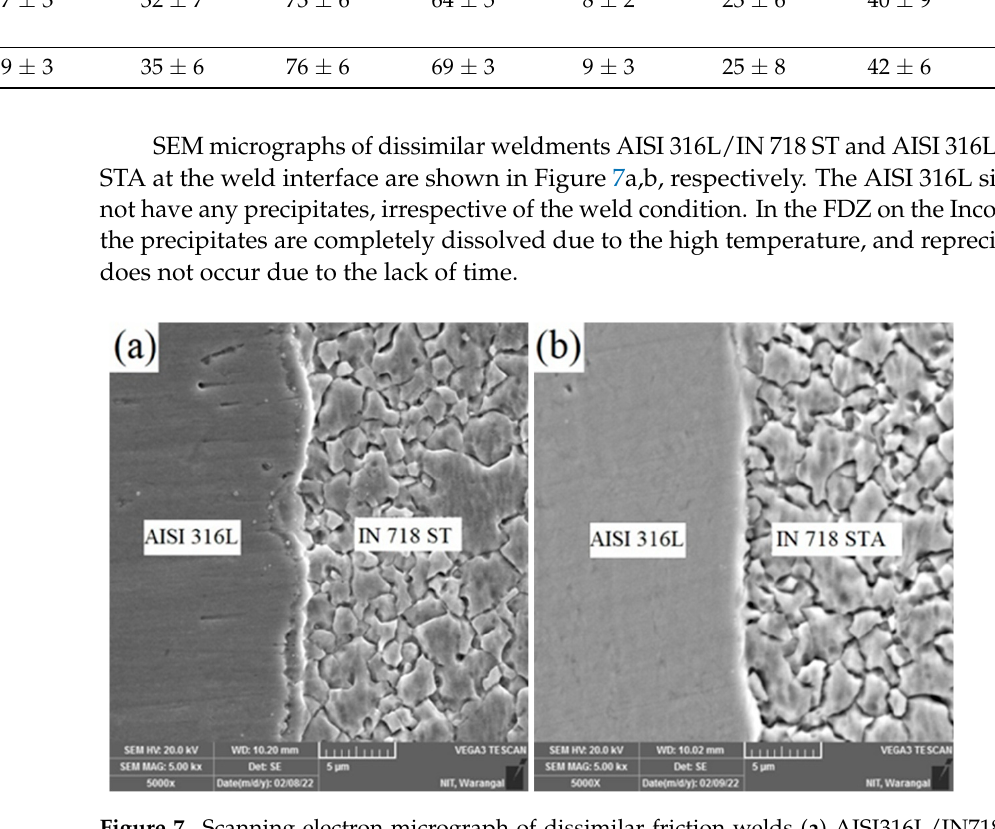
Figure 7. Scanning electron micrograph of dissimilar friction welds ( a ) AISI316L/IN718 ST and ( b ) AISI316/-IN718 STA.